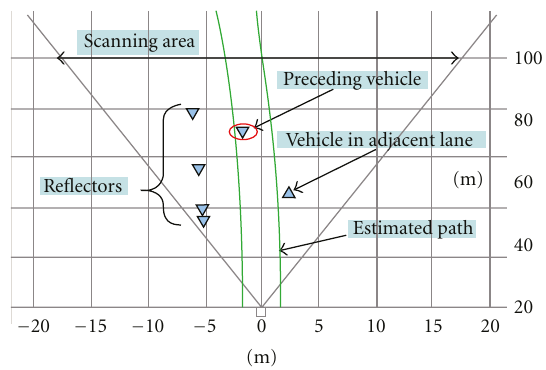
Figure 12: Estimation of tra ffi c lane and recognition of the preceding vehicle.